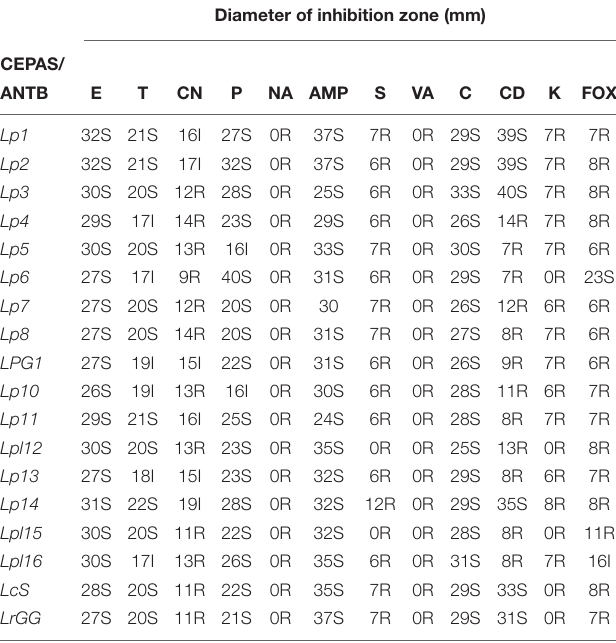
TABLE 5 | Probiotic characteristics for the 16 predominant LAB genotypes obtained in the present study. Diameter of inhibition zone